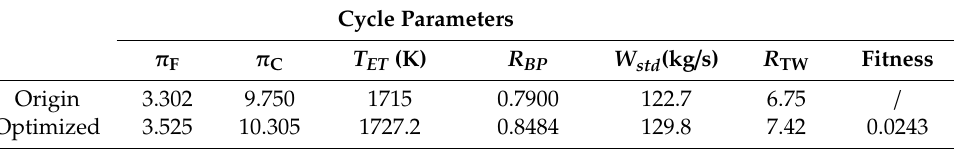
Table 7. The optimal solution of cycle